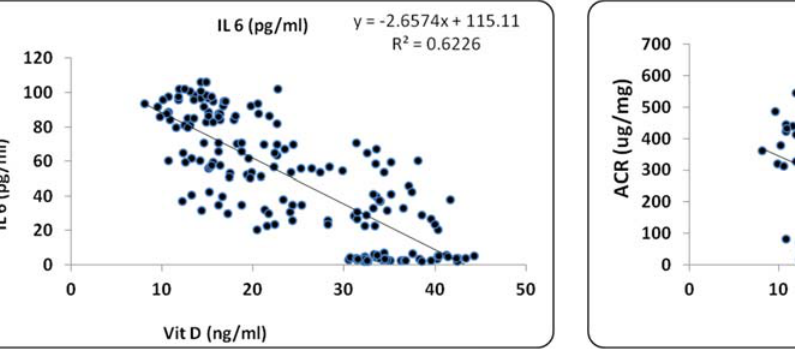
Figure 6: Scatter plot with regression line between vitamin D and ACR.